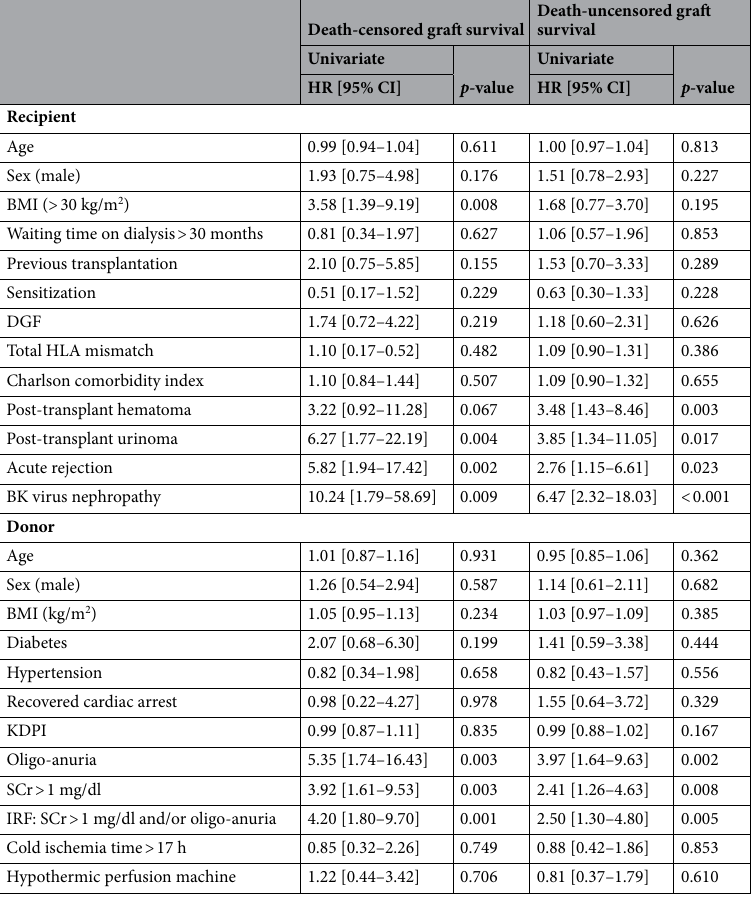
Table 4. Univariate Cox regression model for risk factors of death-censored and death-uncensored graft loss. All variables with a p-value under 0.2 in univariate analyses were introduced in the multivariate models. For all tests, a p-value < 0.05 was considered as significant. BMI Body Mass Index, DGF delayed graft-function, SCr serum creatinine.